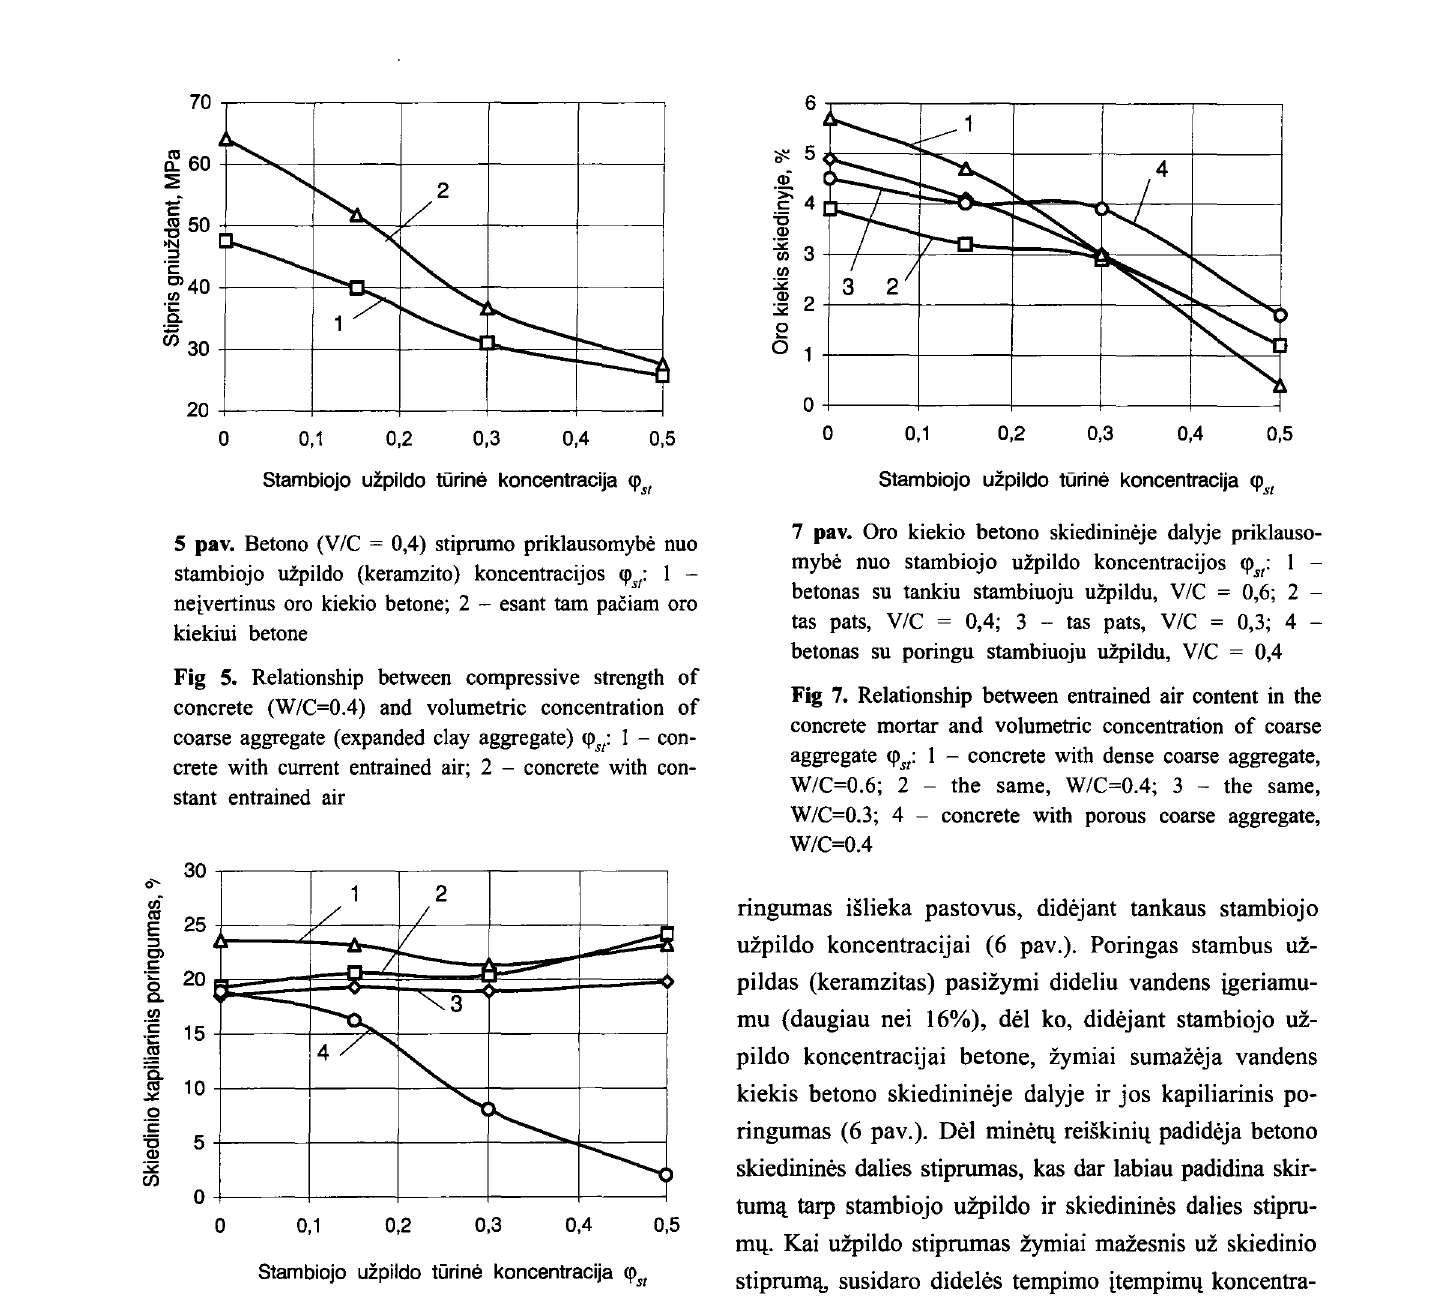
6 pav. Betono skiedinines dalies kapiliarinio poringumo priklausomybe nuo stambiojo uZpildo koncentracijos <i>s,: 1 - betonas su tankiu stambiuoju uZpildu, V/C = 0,6; 2 - tas pats, V/C = 0,4; 3 - tas pats, V/C = 0,3; 4 - betonas su poringu stambiuoju uzpildu, V /C = 0,4 Fig 6. Relationship between capillary porosity of con crete mortar and volumetric concentration of coarse aggregate <ps 1: 1 - concrete with dense coarse aggregate, W/C=0.6; 2- the same, W/C=0.4; 3- the same, W/C=0.3; 4 - concrete with porous coarse aggregate, W/C=0.4